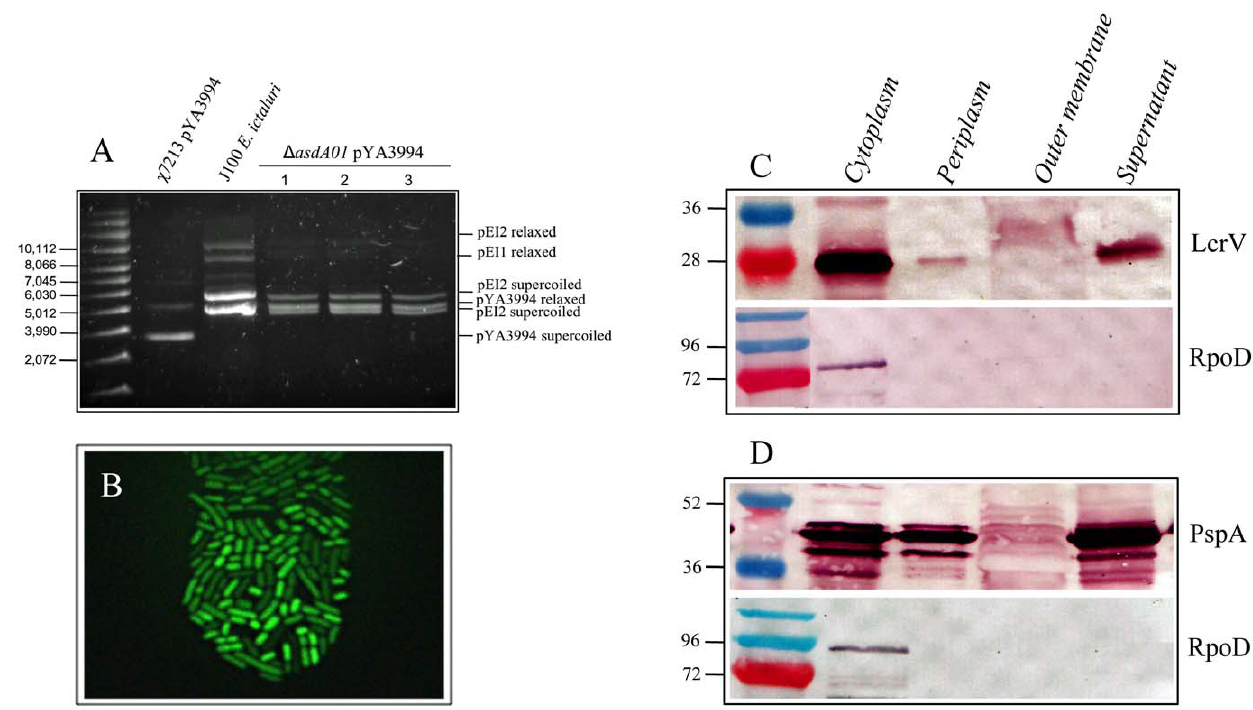
Figure 8. Synthesis of heterologous antigens in E.ictaluri J112 D asdA01 by using AsdA + expression vectors. A. Plasmid profile of J112 (pYA3994); B. Expression of GFP J112 (pYA3994); C . Expression and secretion of Y. pestis LcrV antigen by J112 (pYA3840); D. Expression and secretion